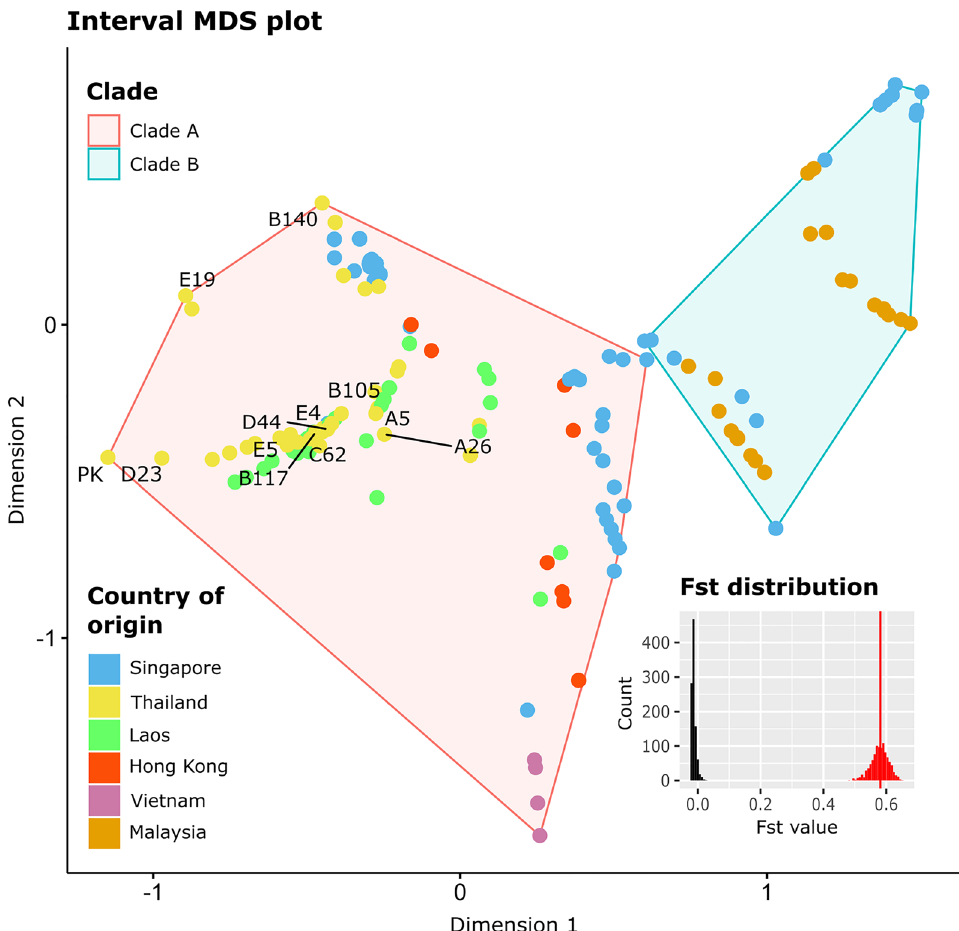
Figure 2. Interval multidimensional scaling plot and fixation index. The function mds in the R library smacof was used to perform interval multidimensional scaling (MDS) on the bacterial pairwise genetic distances extracted from the GBS ST283 tree (Fig. 1). The colors of the data points correspond to the bacterial country of origin (see key). The two convex hulls indicate the two major clades of GBS ST283 as shown in Fig. 1 (red: clade A, blue: clade B). The names of the 12 bacterial isolates whose genomes were sequenced in this study are shown. Pairwise fixation index (Fst) between the two clades was computed by using the function stamppFst implemented in the R library StAMPP (Fst = 0.58, inset histogram, red vertical line). The confidence interval of the Fst estimate was computed by using 1000 bootstrapped genetic datasets (95% confidence interval = 0.52– 0.63, red histogram). Randomization test suggested that the clade assignment explained a significant portion of the bacterial genetic diversity (N = 1000, range null Fst values = − 0.022–0.026, p-value < 0.001, black histogram). The figure was generated using R with the ggplot2 3.3.5 54 R library, and was arranged and labeled in Inkscape 1.0.2-2 56